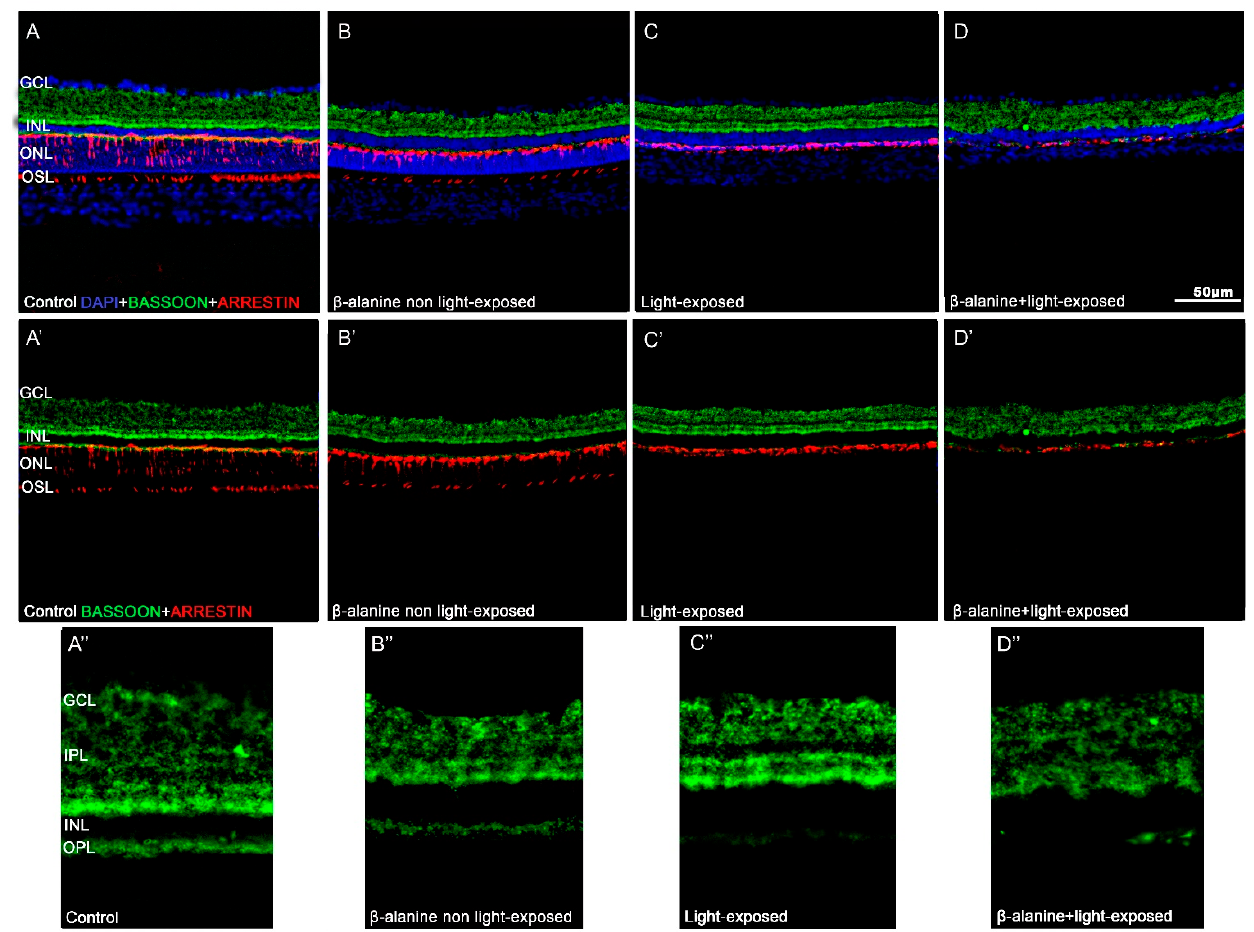
Figure 6. Bassoon immunoreactivity. Photomicrographs of retinal cross sections taken from representative animals of the different subgroups: Control ( A , A ′ , A ″ ), β -alanine non light-exposed ( B , B ′ , B ″ ), light-exposed ( C , C ′ , C ″ ), and combined β -alanine and light-exposed ( D , D ′ , D ″ ) rats showing bassoon ( green ) and arrestin ( red ) immunoreactivity. Figures ( A – D ) are the same shown in A ′ –D ′ but include DAPI counterstaining ( blue ). Figures A ″ –D ″ show high power magnifications of the microphotographs shown in A ′ –D ′ . Bar: 50 µm. GCL: Ganglion cell layer. IPL: Inner Plexiform layer. INL: Inner nuclear layer. OPL: Outer Plexiform layer. ONL: Outer nuclear layer. OSL: Outer segments layer.